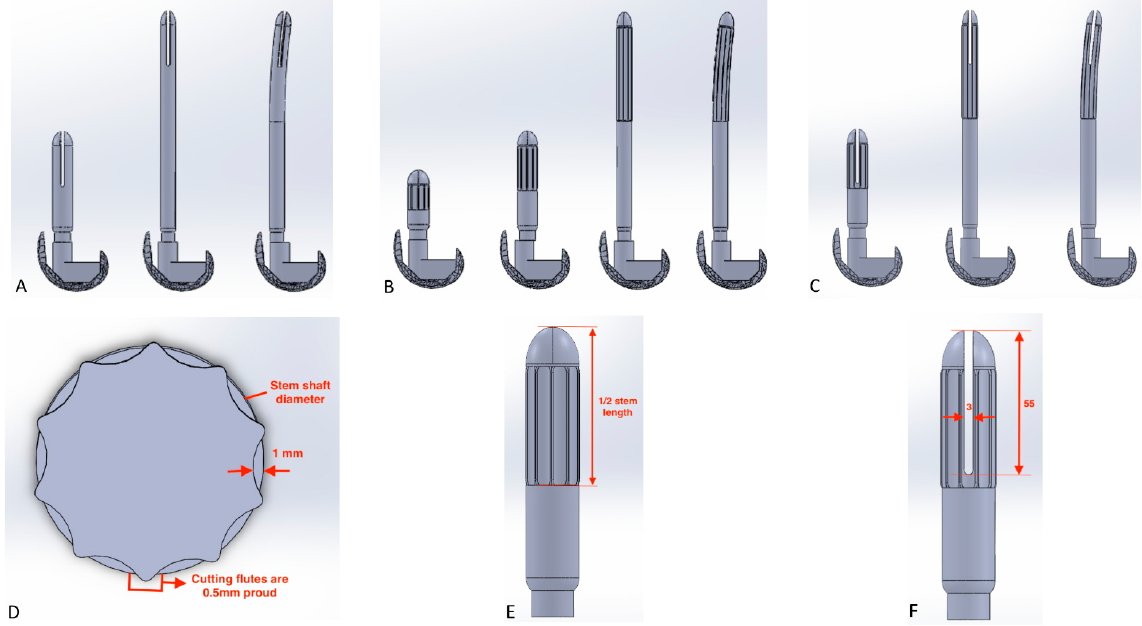
Figure 2. Design of the different stems analyzed in the present study with different features: ( A ) Slotted stems—from the left to the right, 160 mm stem, 280 mm straight, and bowed stems; ( B ) Fluted stems—from the left to the right, 160 mm stem, 280 mm straight, and bowed stem; ( C ) Fluted and slotted stems—from the left to the right, 160, 280 mm straight, and 280 mm bowed stems; ( D ) Design of the fluted stem, transversal cut; ( E ) Lateral view of the fluted stem; ( F ) Lateral view of the slotted stem. All the measurements are expressed in mm.